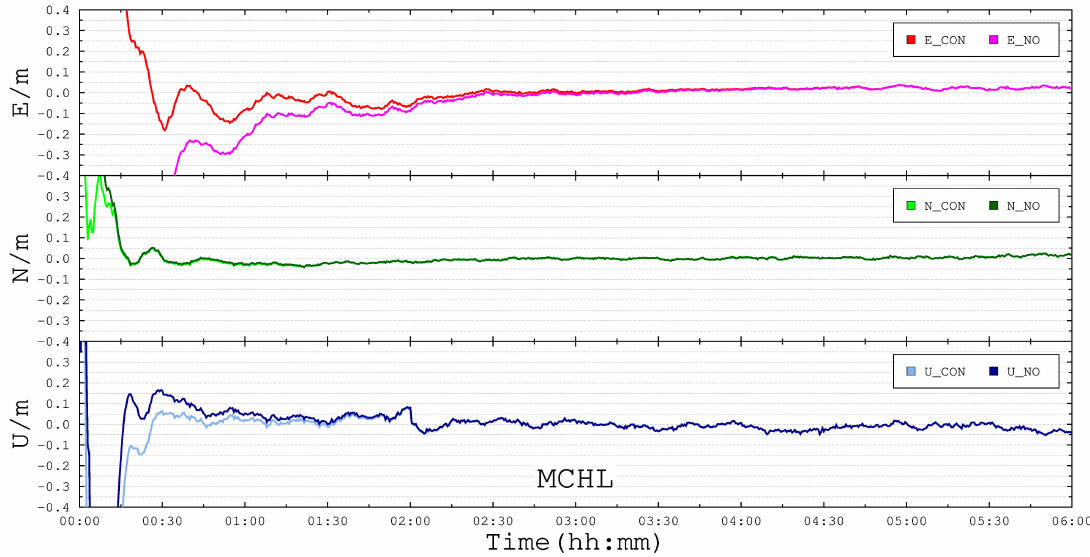
Figure 18. The kinematic PPP solutions of station MCHL at DOY 097,